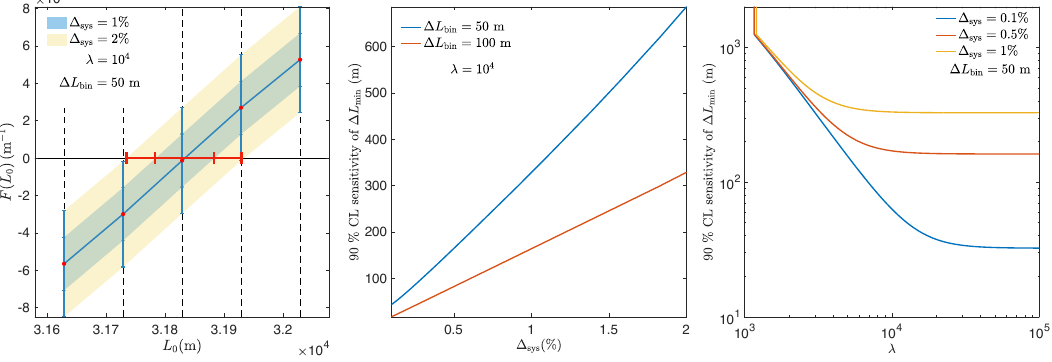
Figure 15 . The left plot shows how we determine L min for neutrinos with 30 MeV energy and its uncertainty (red error bars) from eq. (4.11) (blue error bars) considering two different systematic uncertainties labeled in the plot. Here we consider the JSNS setup by taking eq. (4.13) for N ( E ) in 0 eq. (4.10), and each bin is separated by the black dashed lines, hence the parameters which would influence the uncertainty of L are the systematic uncertainty ( ∆ ), the statistical uncertainties min sys ( λ : increment w.r.t. the JSNS set up) and the bin size ( ∆ L ). The middle and right plot show bin how these parameters would influence the sensitivity for ∆ L through simulating the uncertainties min of L . In particular, the middle plot corresponds to eq. (4.12), and the right plot shows when min systematic/statistic uncertainties dominate over one another. Specific steps to determine L and min more discussions on the plots are given in the